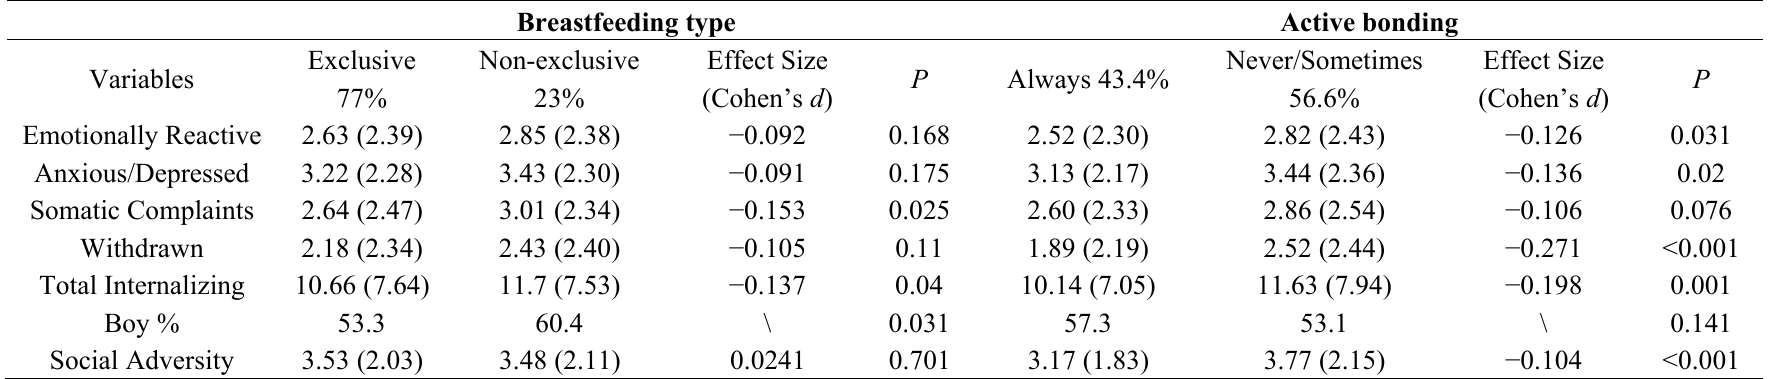
Table 1. Descriptives of the Breastfeeding and internalizing behavior Outcome ( N = 1267).